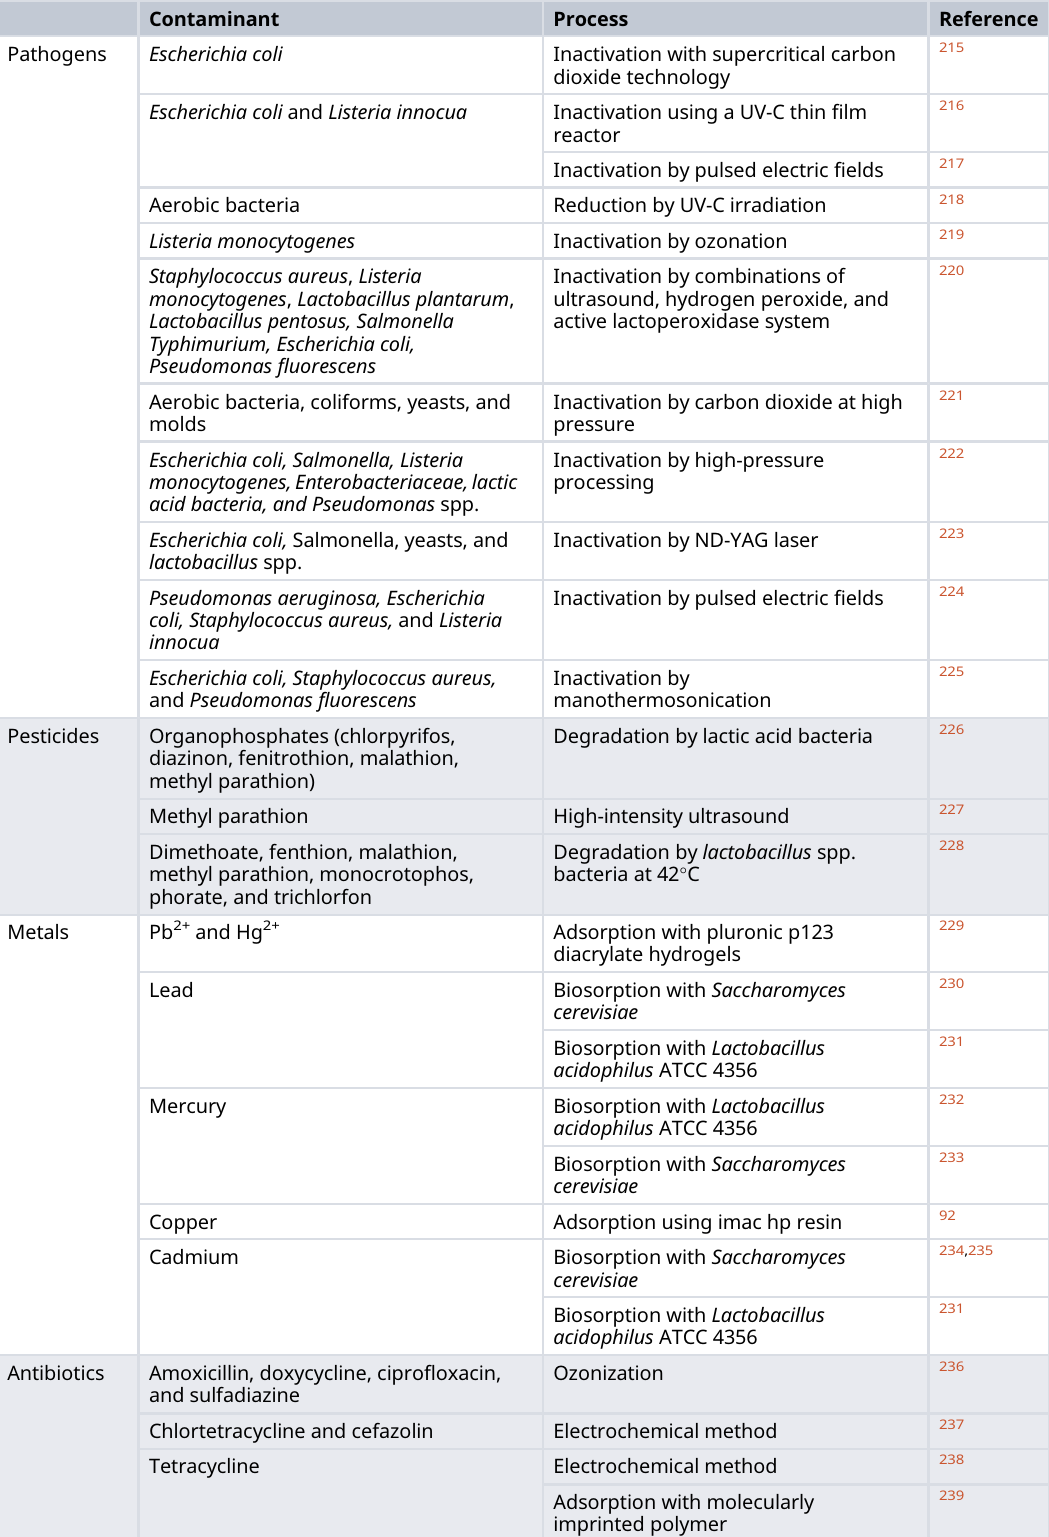
Table 3. Alternative methods to pasteurization for removal of contaminants in bovine